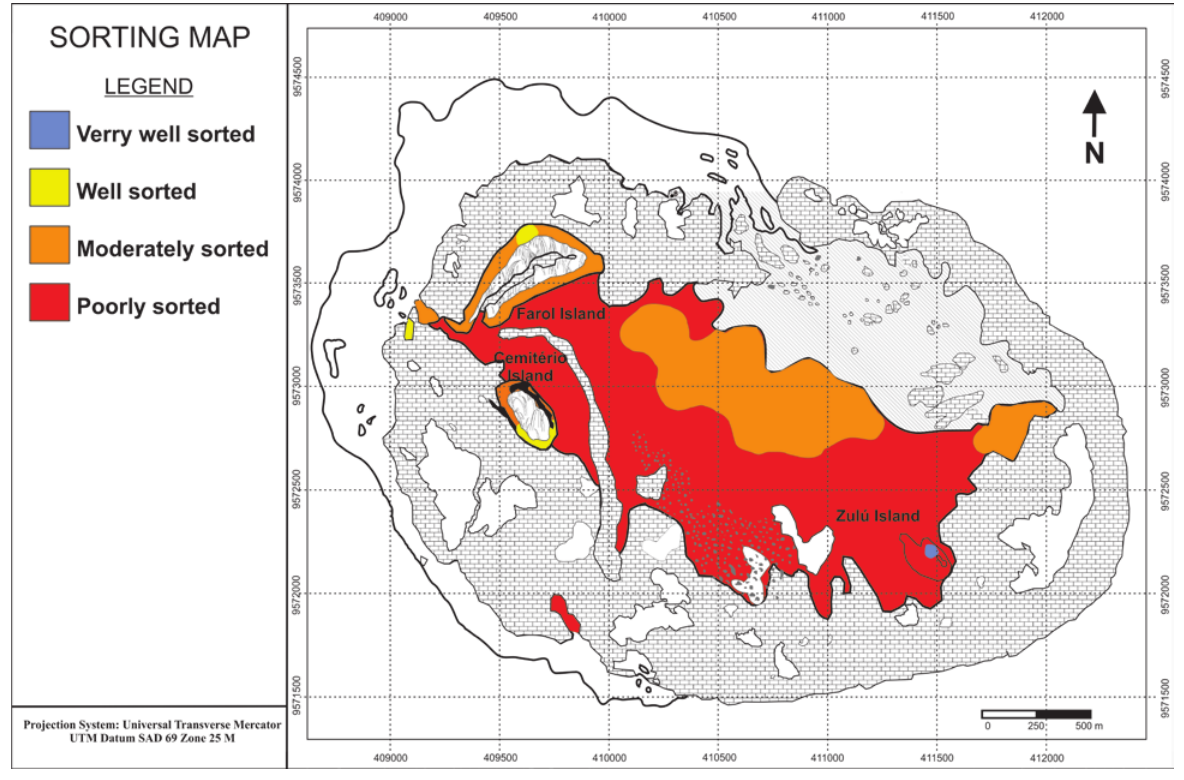
Figure 09 - Sorting map of Rocas